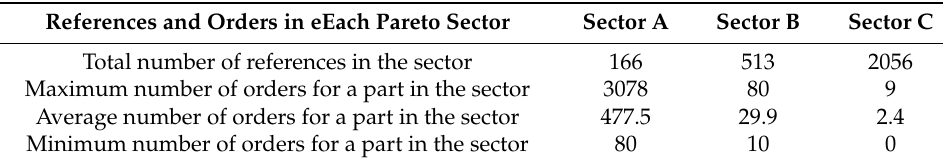
Table 1. Pareto distribution A-B-C of all references. Elaborated by the authors from thanks to the data facilitated by Unistral Recambios data.